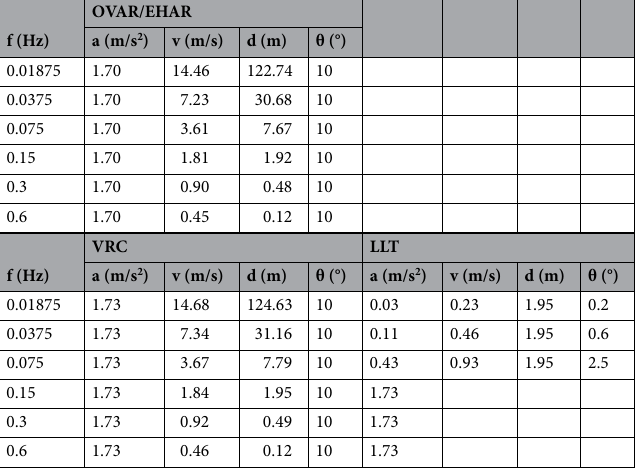
Table 2. Stimulus parameters for the various motion paradigms at each frequency. F frequency, a linear acceleration, v linear velocity, d peak-to-peak amplitude, θ tilt